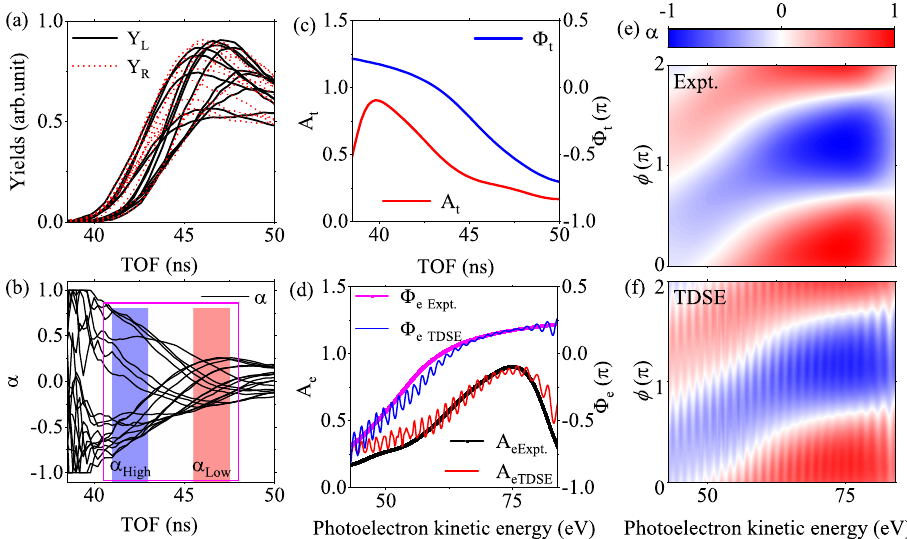
Figure 2. ( a ) Typical time-of-flight (TOF) photoelectron distributions measured by the left and right detectors of CEPM at a series of CEPs. ( b ) The TOF-dependence of the left-right asymmetry ( α ( φ , t )